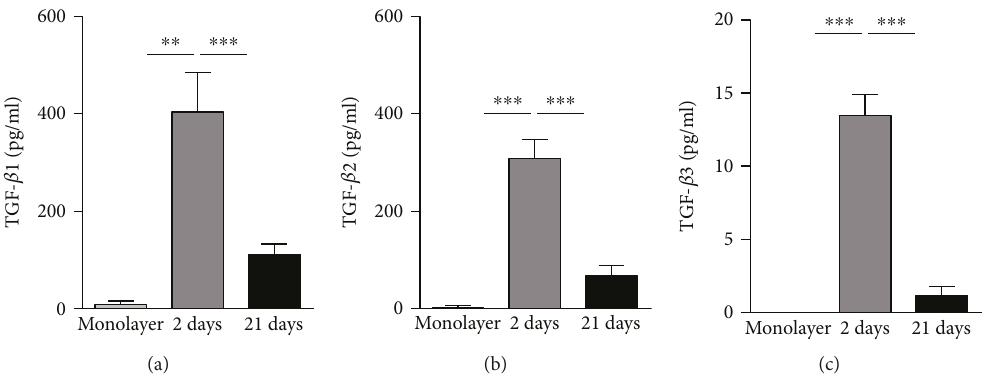
Figure 4: The CPC spheroids formed in the micromolded nonadhesive hydrogel with 800 μ m diameter in each circular recesses showed an increase in TGF- β 1, TGF- β 2, and TGF- β 3 synthesis comparing to CPCs monolayer. The CPC spheroids maintained for 2 days (spheroid compaction) in cell spheroid culture showed the highest synthesis of TGF- β 1 (a), TGF- β 2 (b), and TGF- β 3 (c) comparing to the CPC spheroids maintained for 21 days (spontaneous chondrogenesis) and to monolayer ( ∗∗ p < 0 01 , ∗∗∗ p < 0 005 ). TGF-beta: transforming growth factor-beta.